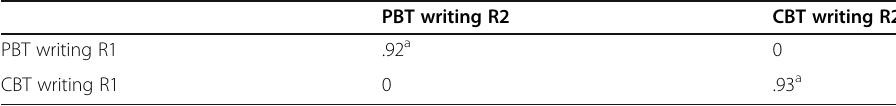
Table 3 Inter-rater